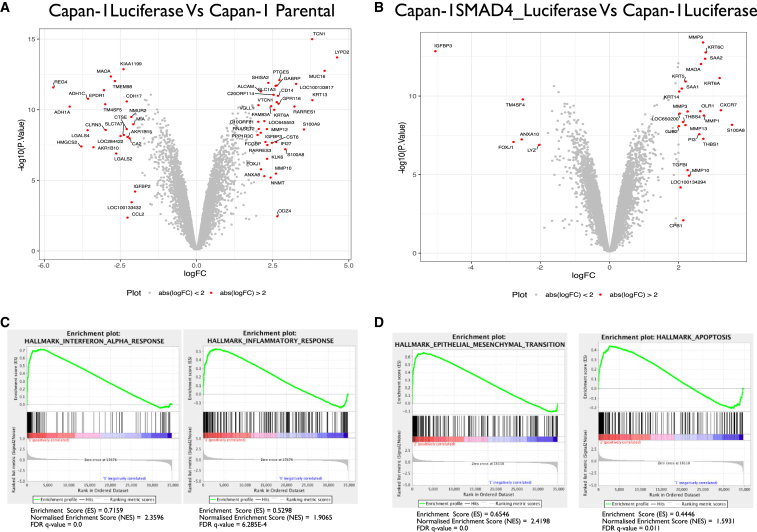
Genome-wide Transcriptome Analysis of modified Capan-1 cells(A and B) Volcano plots showing the gene expression changes of Capan-1 luciferase versus Capan-1 parental (A) and Capan-1 SMAD4-luciferase versus Capan-1 luciferase (B). Highlighted in red are genes with a fold change of 2 and p < 0.05. (C) Gene set enrichment analyses (GSEA) of interferon-α and inflammatory response in Capan-1 luciferase versus parental cells. (D) GSEA of epithelial-to-mesenchymal transition and apoptosis signature in Capan-1 SMAD4 versus Capan-1 luciferase cells. ES, enrichment score; NES, normalized enrichment score; FDR, false discovery rate.